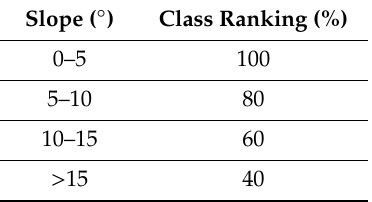
Table 1. Categorization by mechanical accessibility of the slopes in Italian vineyards.